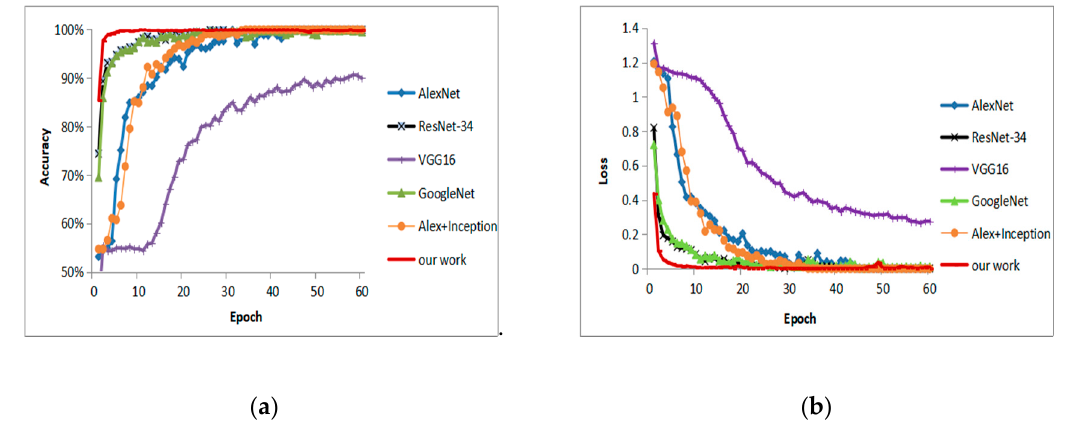
Figure 7. Convergence comparison: ( a ) accuracy values; ( b ) loss values.